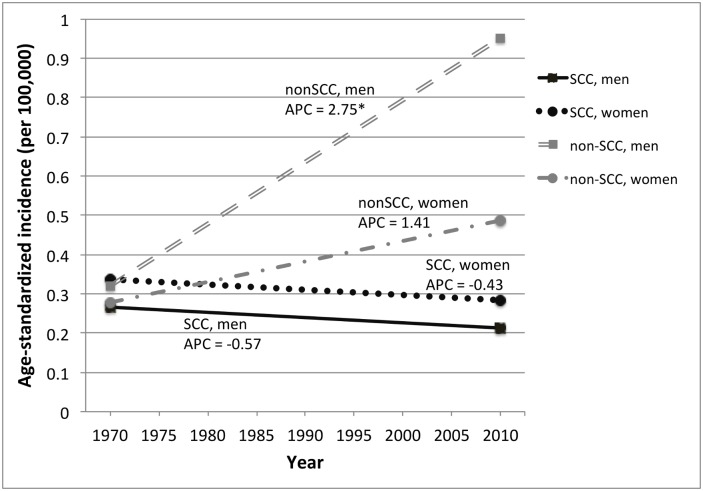
Incidence of invasive anal cancer in Singapore, 1968–2012, by gender and histology.Incidence trends are based on incidence rates for 5-year time periods that were age-adjusted to the WHO standard population. Annual percent change (APC) was calculated using Joinpoint regression analysis. APC = annual percent change. An asterisk (*) indicates an APC value that is statistically significant at p≤0.05. Abbreviations: SCC = squamous cell carcinoma, non-SCC = non-squamous cell carcinoma